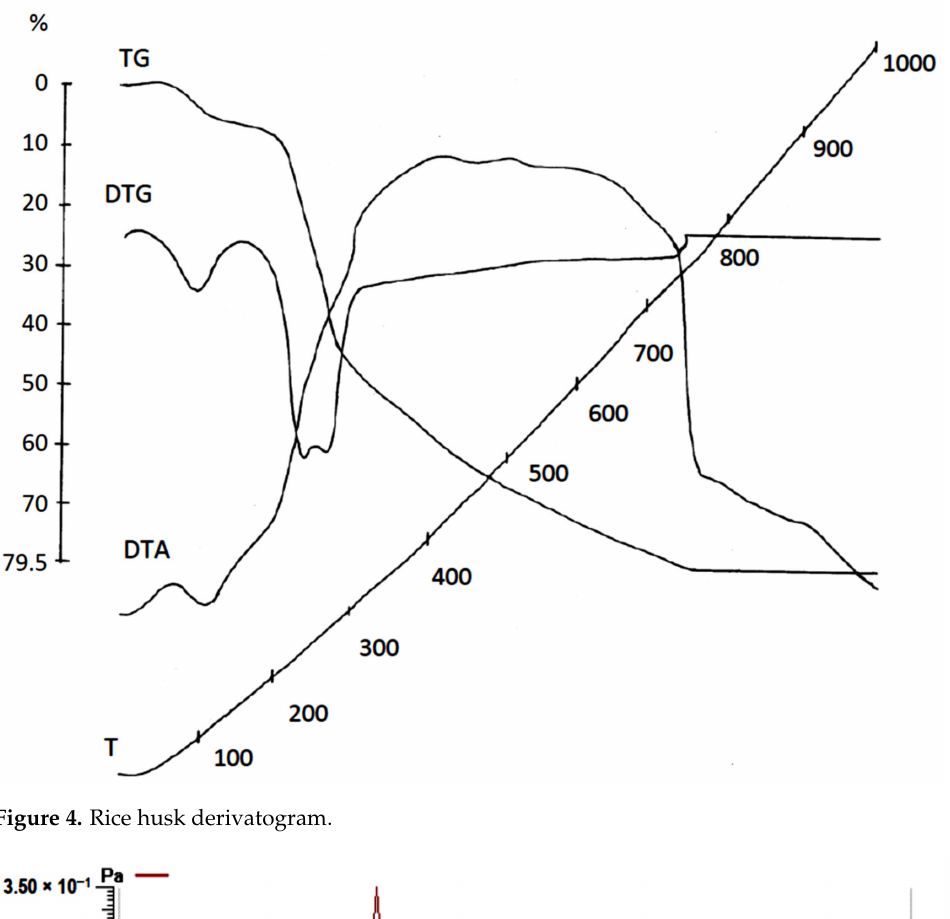
Figure 4. Rice husk derivatogram.